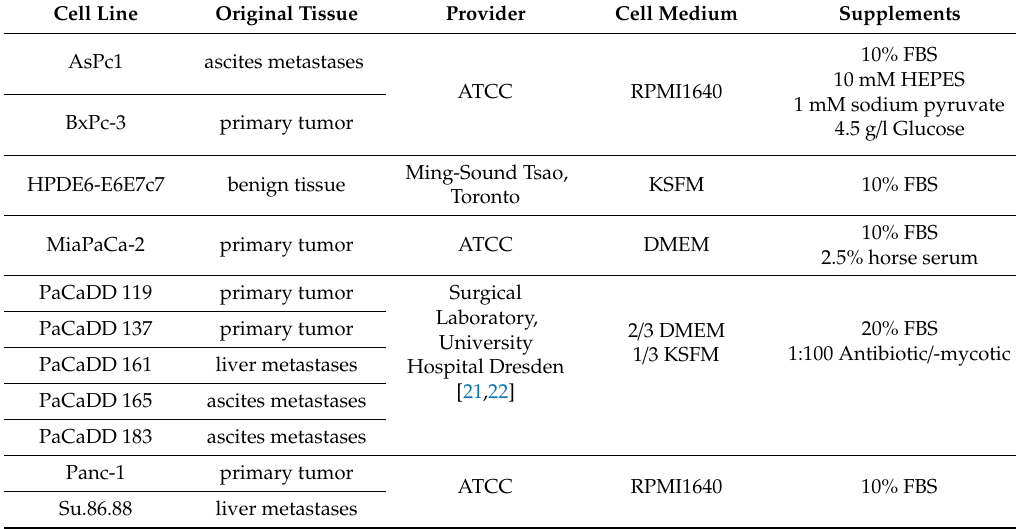
Table 7. Overview of used cell lines, their origin and culture